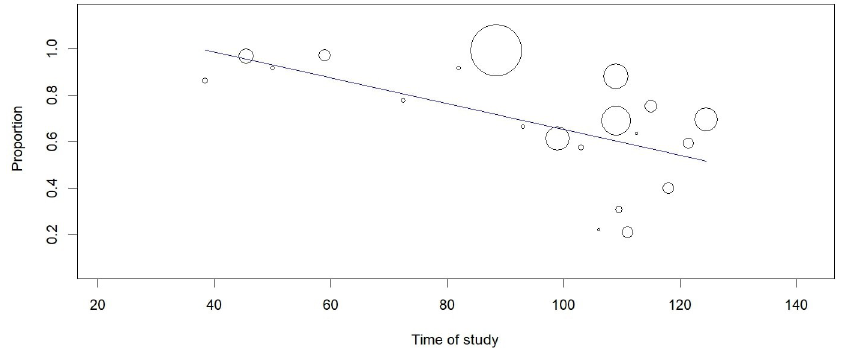
Fig 6. Meta regression for the effect of time on mortality outcome in IMV for COVID-19.